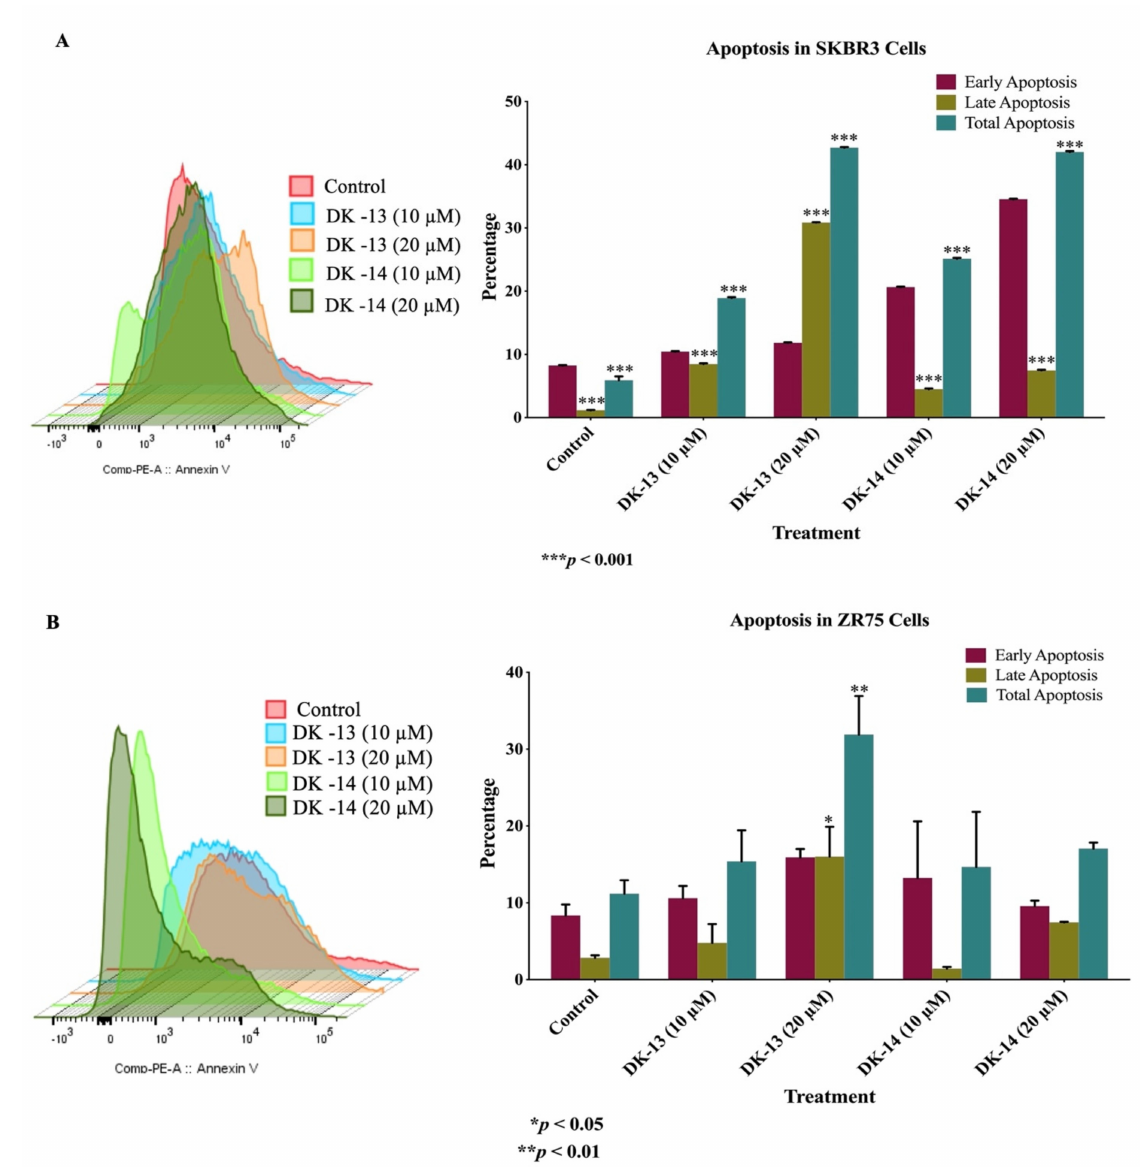
Figure 3. ( A , B ). Impact of chalcone compounds (DK-13 and -14) on cell apoptosis at quantities of 10 and 20 µ M in ( A ) SKBR3 and ( B ) ZR75 cell